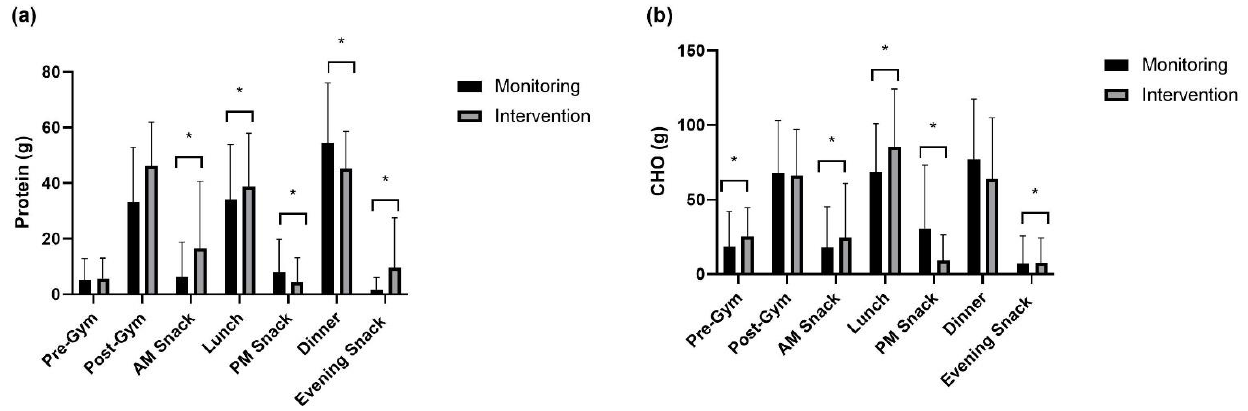
Figure 3. Absolute between-meal intake on high-volume training days of ( a ) protein and ( b ) carbohydrate. * signifies a significant difference in intake between monitoring and intervention periods.